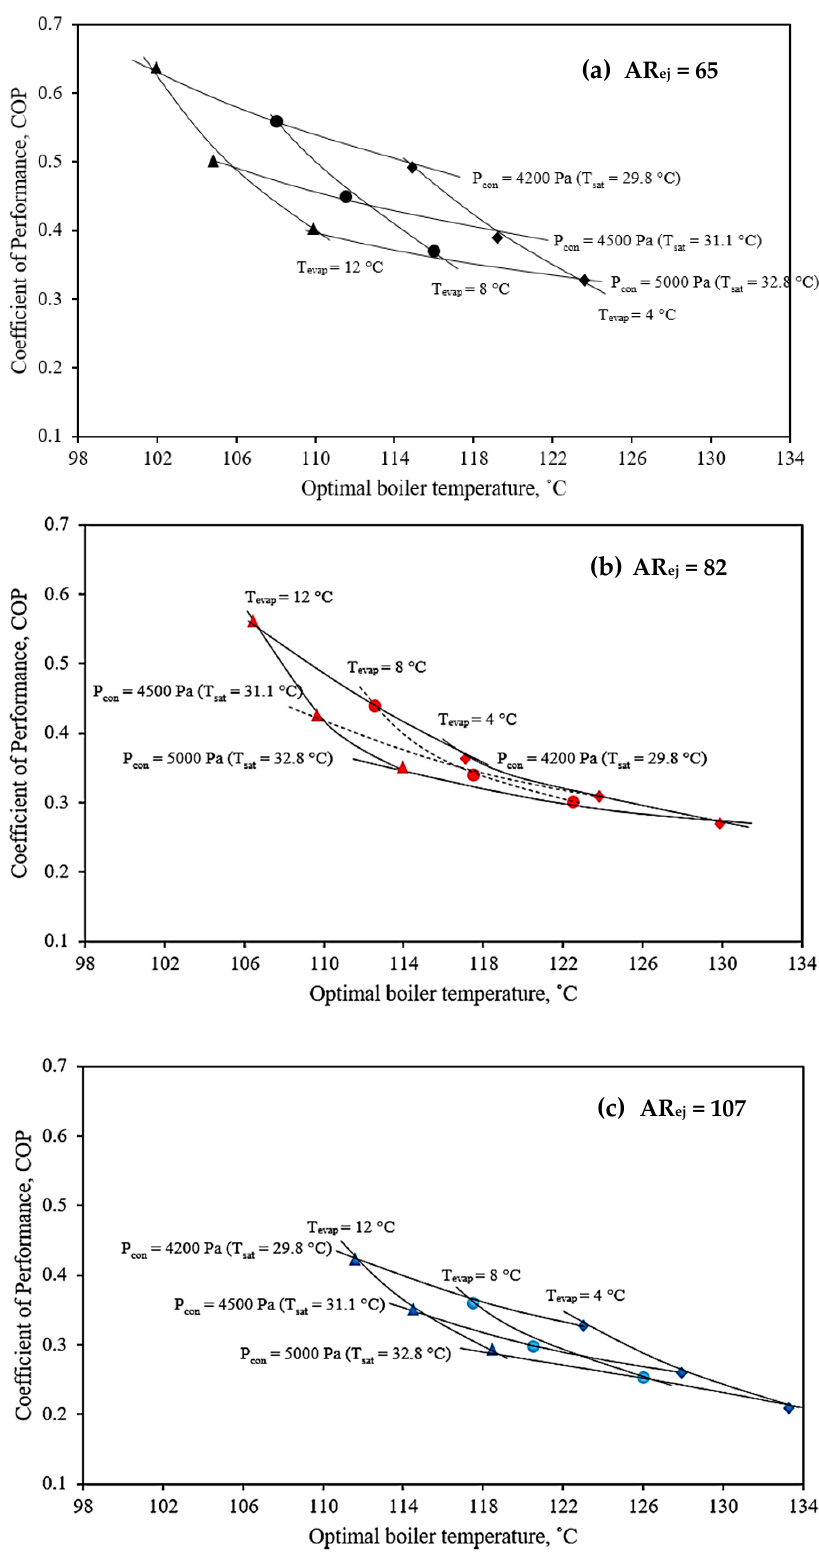
Figure 9. The optimal performance map under various working conditions and the ejector area ratios.